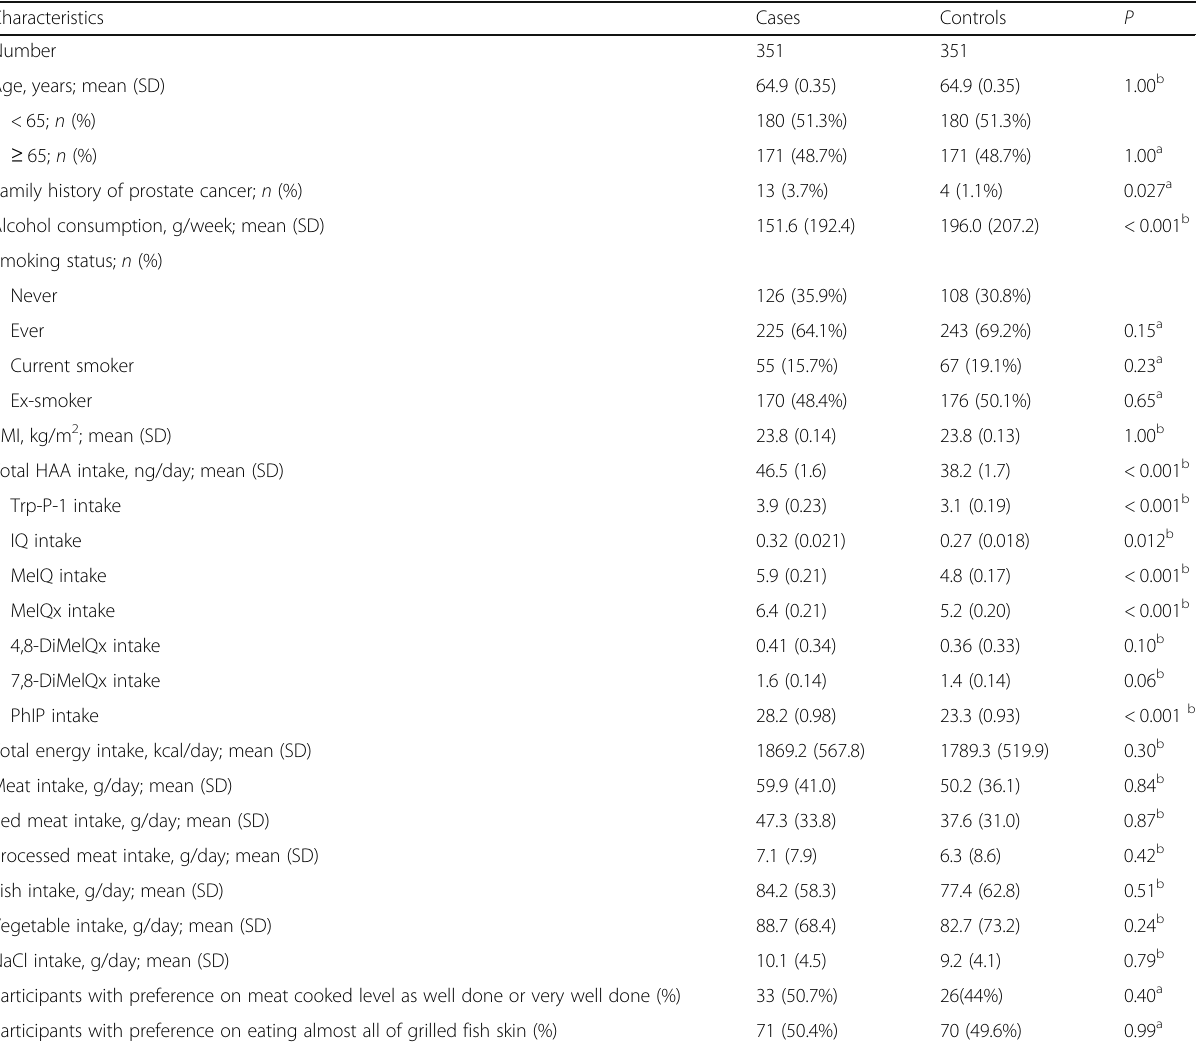
Table 1 Characteristics of cases and controls